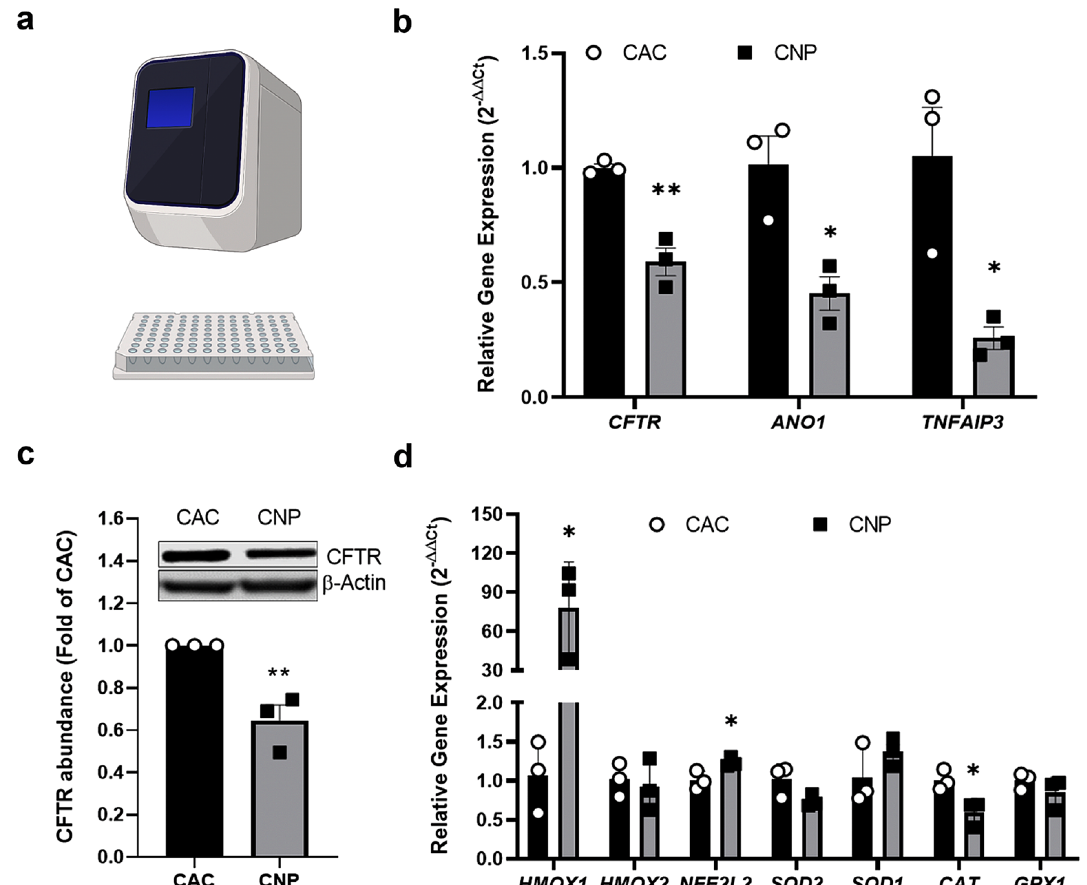
Figure 3. Analysis of CFTR and oxidative stress related genes expression ( a ) Schematic representation of a qPCR device and a plate used for the analysis. ( b ) ALI-cultured 16HBE14o- cells were exposed to spark- ablated CNP generated with 8 L/min nitrogen gas flow, 1.0 kV gap voltage and 5 mA at day 5 of ALI and gene expression of CFTR , ANO1 and TNFAIP3 was measured by qPCR, normalized to PGK1 expression. Data are mean ± SEM of three independent experiments. Each experiment was measured with two technical replicates. Two-tailed, unpaired student ‘s t-test, * p < 0.05, ** p < 0.01. ( c ) From the same cells proteins were isolated and 30 µg protein were subjected to western blot analysis (cropped image, depicted are lane 4 and 5 of Fig. S9 with the full western blot image with 3 biological replicates) for CFTR and β-Actin as reference protein. Data are expressed as fold of CAC samples. Data are mean ± SEM of four independent experiments. Two-tailed, unpaired student ‘s t-test, ** p < 0.01. ( d ) A panel of markers for oxidative stress was analyzed by qPCR. Data are mean ± SEM of three independent experiments. Each experiment was measured with two technical replicates. Two-tailed, unpaired student ‘s t-test, * p <